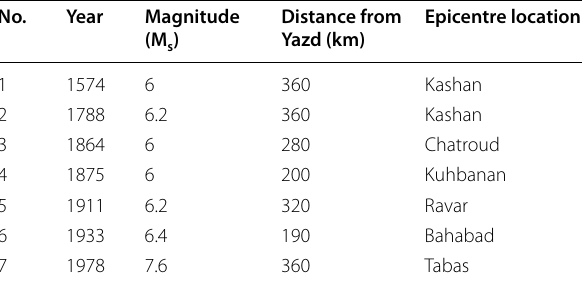
Table 3 Main destructive earthquakes that occurred in regions neighbouring the city of Yazd (Source: Nikouhemat 1979; Ambraseys and Melville 2005; Eshghi et al. 2003)